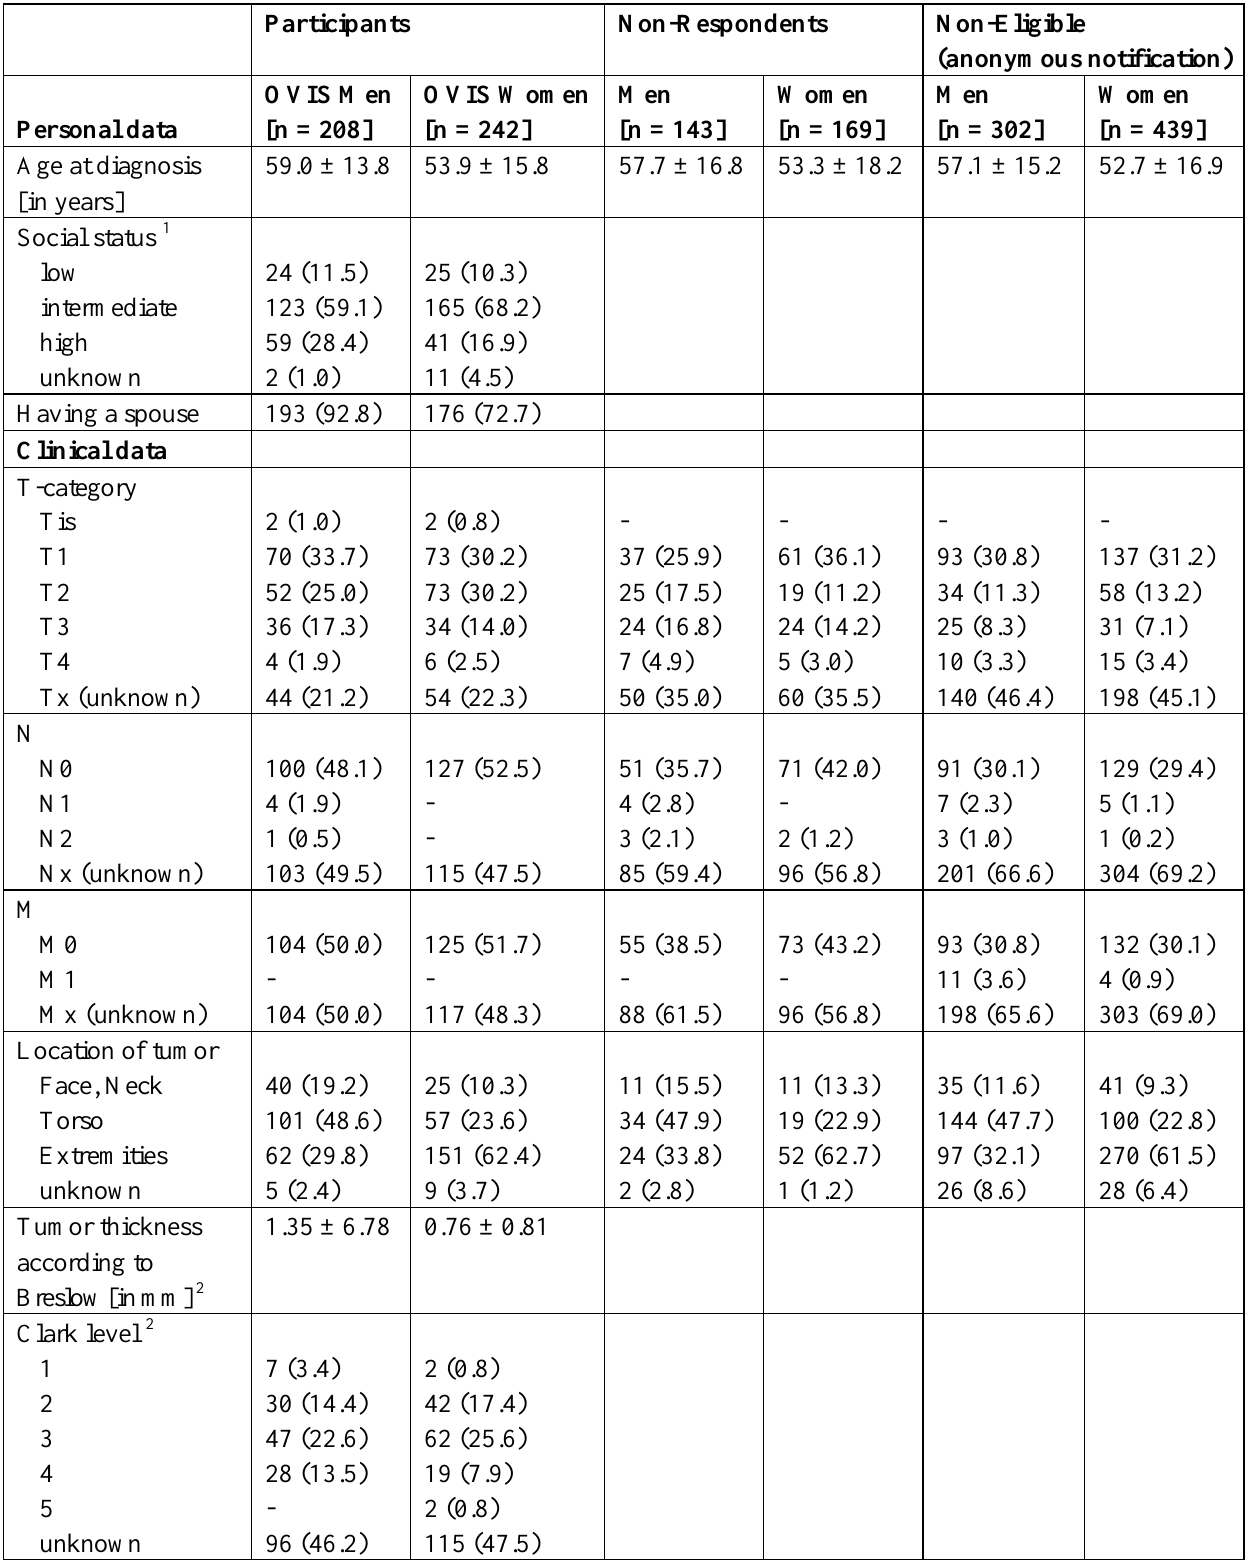
Table 1. Baseline characteristics of 450 patients with incident melanoma shown as absolute (relative) frequencies or means ±